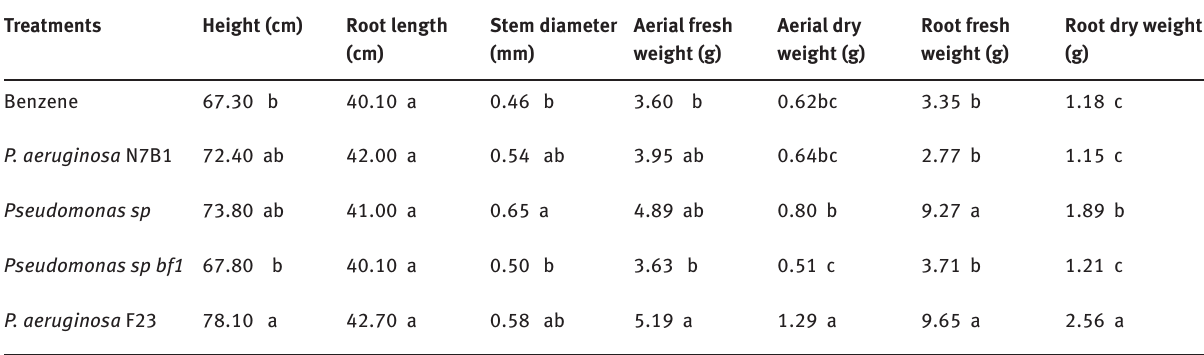
Table 1 : Pseudomonas strains inoculation and aromatic hydrocarbons (with benzene 1000 ppm) effect, on maize growth